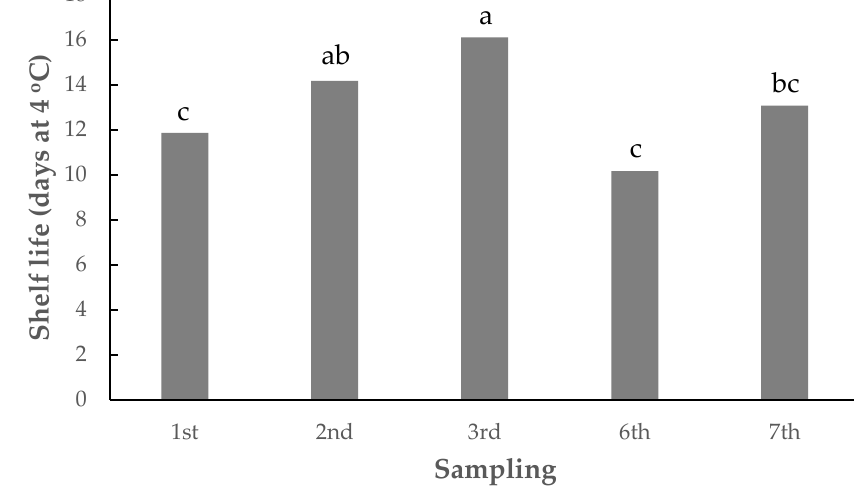
Figure 4. Shelf life of baby spinach leaf stored at 4 °C as affected by growing season. Columns with different letters are significantly different ( a < 0.05).